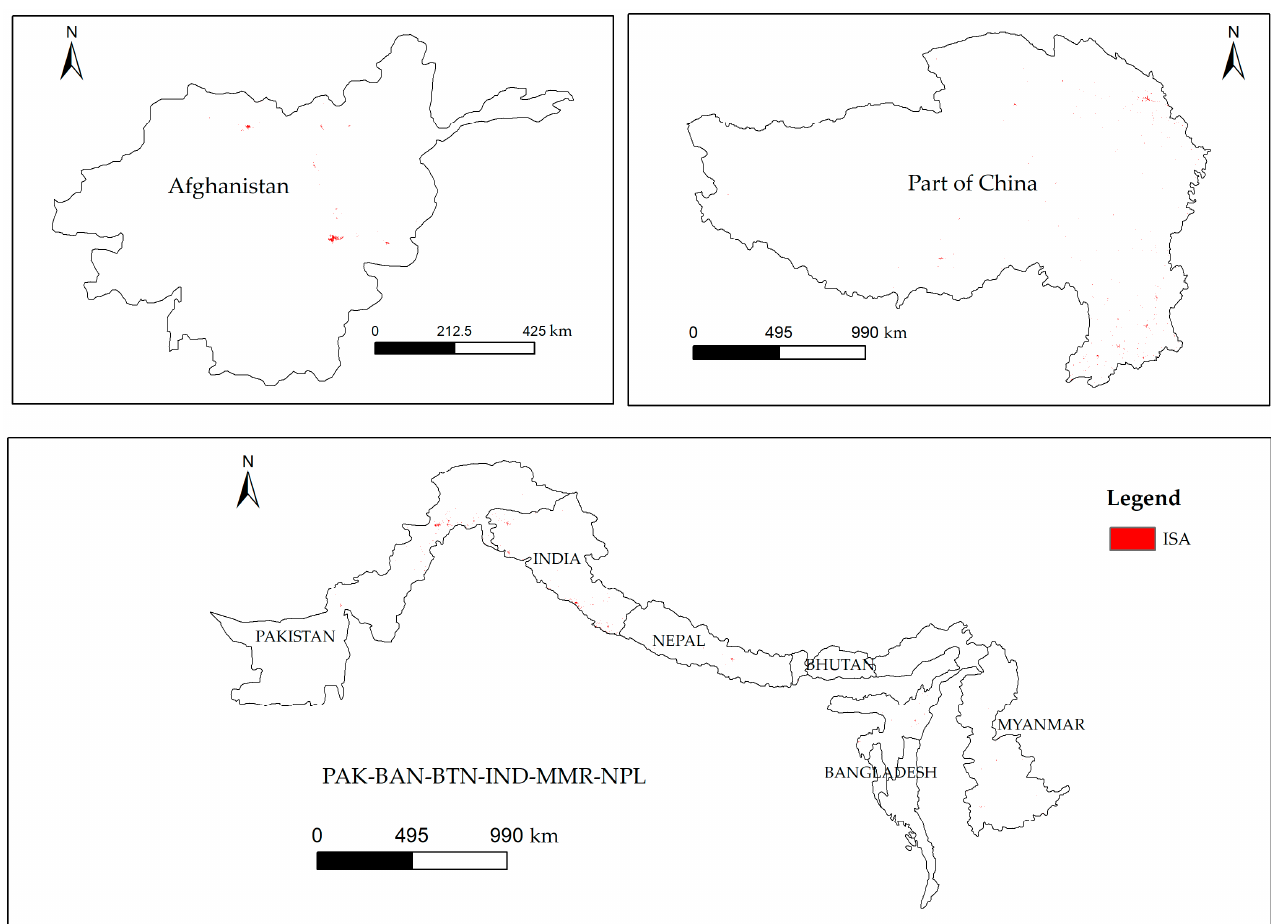
Figure 6. Diagram of the spatial distribution of the ISA for the three divided areas.